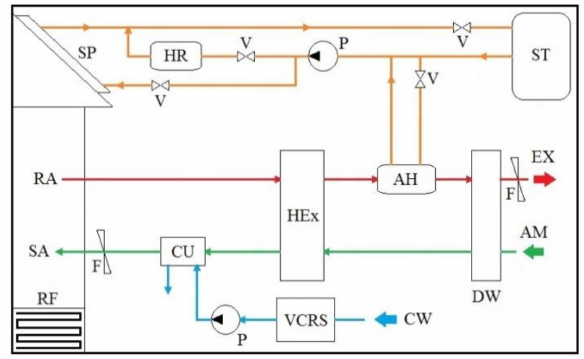
Figure 12. Schematic of Solar desiccant cooling system with radiant floor.